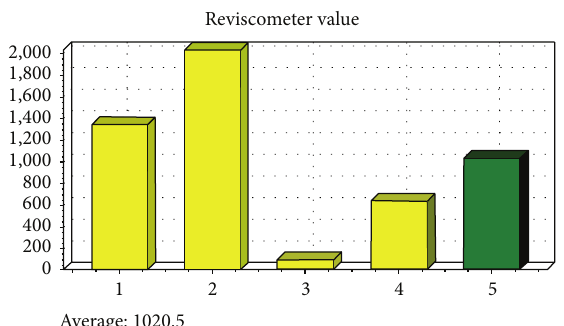
Figure 1: The diagrams provided by Reviscometer RVM 600 probe after measurement of